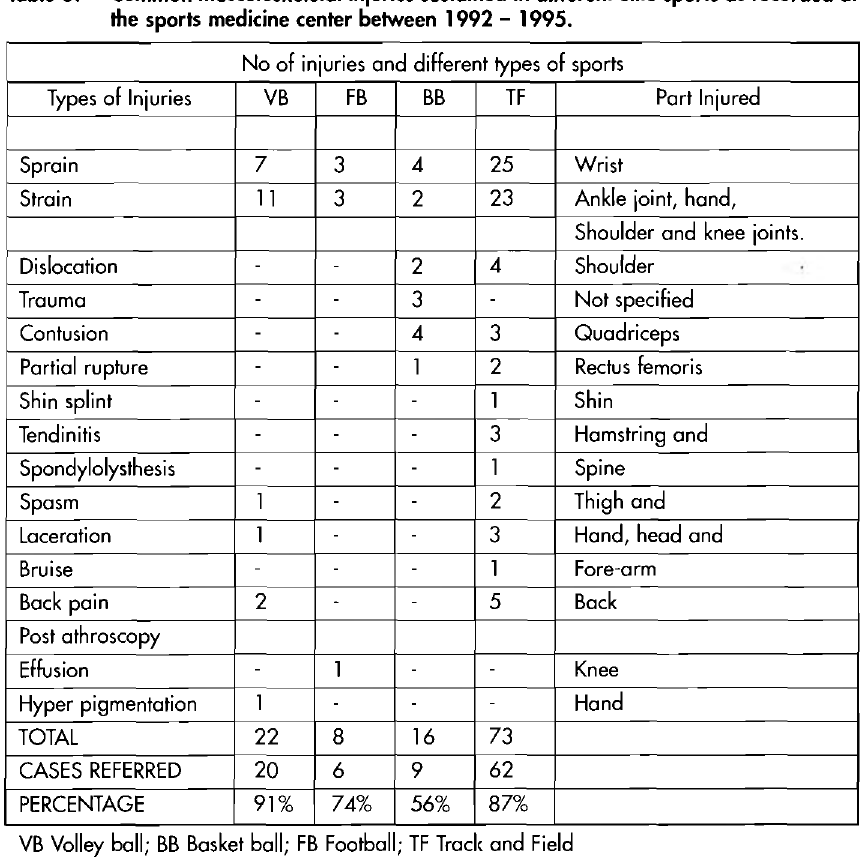
Table 5. Common musculoskeletal injuries sustained in different elite sports as recorded at the sports medicine center between 1992 -